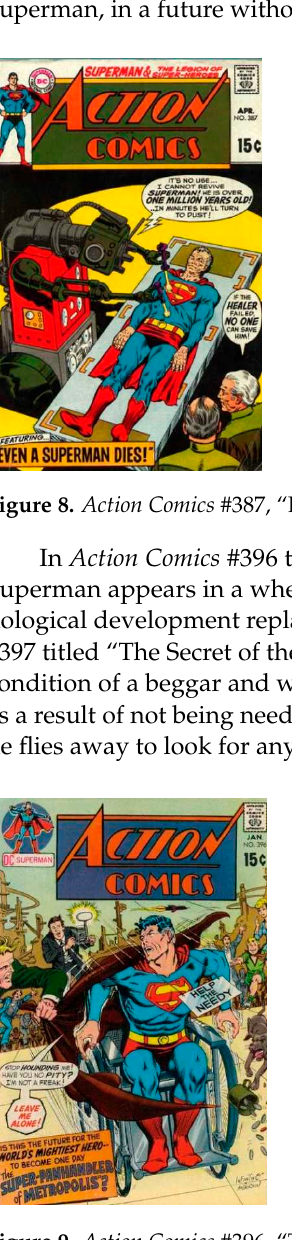
Figure 10. Action Comics #397, “The Secret of the Wheel-Chair Superman!” (February 1971) [10] . In a nutshell, what can be found in the different issues of Superman in Action Comics since 1939, is an unchanged portrayal of the Man of Steel, representing the American icon who dwells for the well-being of American citizens. His archetypical representation of a broad-chest muscular man with superpowers is key for the development of different plots throughout history. As Brooker puts it, “Superheroes emerge from this same mythic tra- dition, but are changed and further mutated by the historical context of their develop- ment” [7] (p. 365). Even though Superman has undergone different changes mirroring the key events in American society, he has not evolved physically except for the eight exam- ples discussed, where the authors experiment with alternative realities, but doing so, they do nothing but perpetuate a biased portrayal of an aged man with white hair, wearing glasses or being prostrate in a wheelchair, with fading superpowers due to his age and, especially, as an inactive agent, set apart from society because he is no longer productive or needed. This portrayal coincides with the one coined in society that has been challenged these last few decades. This reductionism of the later stage of life to frailty and decay has long been fought against, and new policies have been implemented with the concept of ‘active’ or ‘positive’ aging, where old people have been empowered to take an active role in their life and well-being [12,13]. This recent tendency on the social level goes far beyond the efforts of science, which, instead, looks for ways to slow down the process of aging. 5. Superhero and Myth The fact that Superman never grows old can be explained through the theory of ‘mythification of images’, attributing to them an iconic value [14]. In the Middle Ages, this theory consisted in allocating symbolic meanings to certain images by clericals in order to embed them in collective consciousness. This was done by capturing the iconic value of